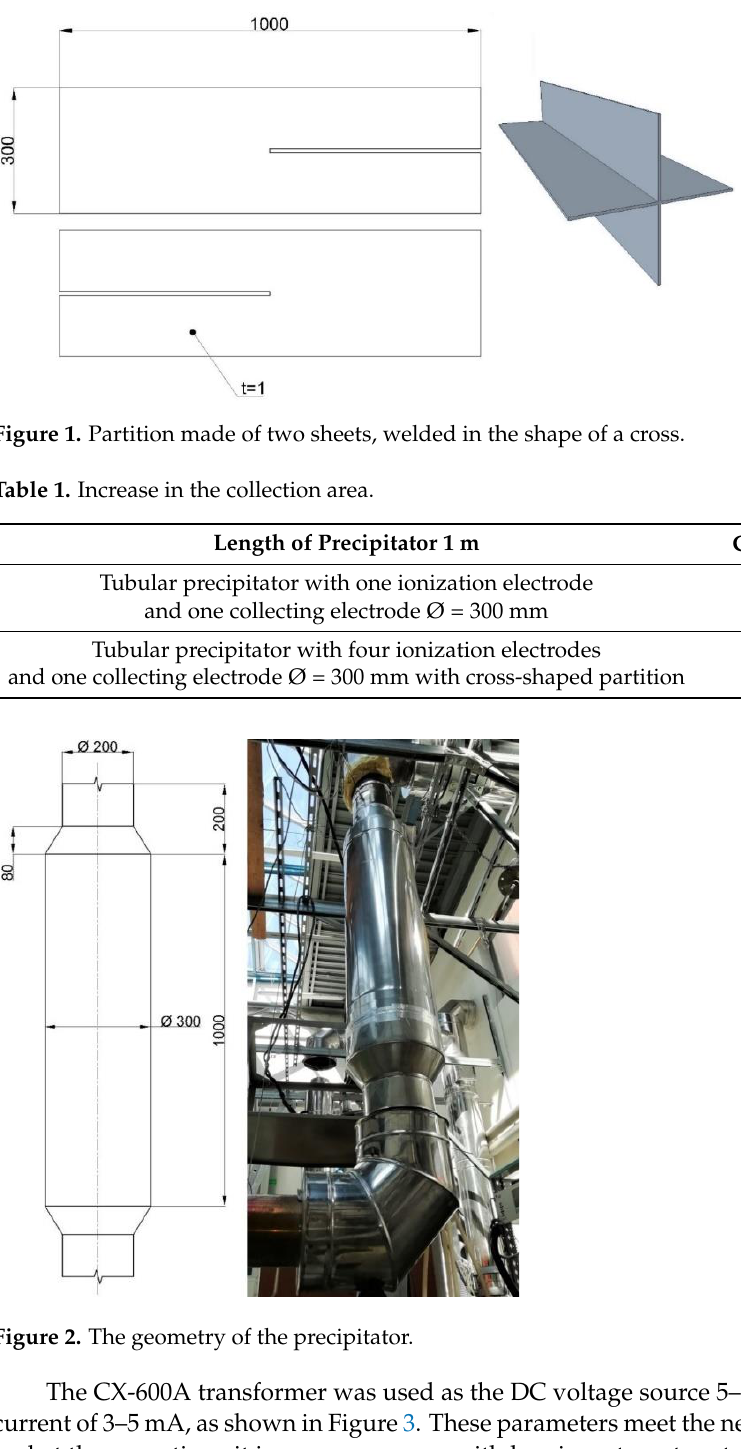
Figure 2. The geometry of the precipitator.